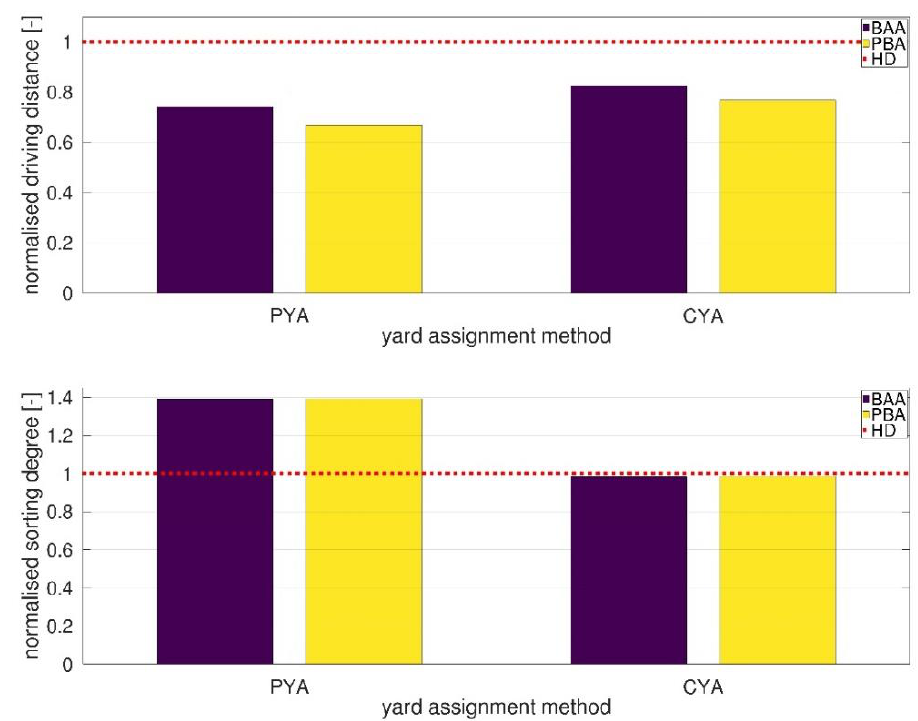
Figure 11. Normalized driving distances and sorting degrees for yard and berth methods.